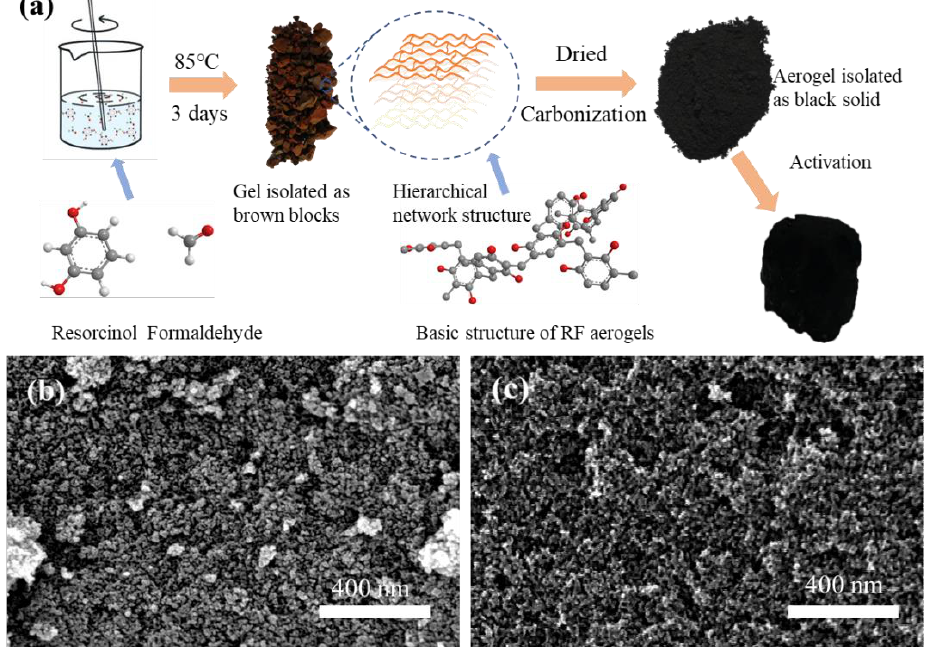
Figure 1. Fabrication and morphology of carbon aerogels. ( a ) Schematic illustration of the fabrica- tion process. Resorcinol and formaldehyde hydrosol were converted into hydrogel by hydrothermal process, freeze-dried for 24 h, and annealed at 900 °C to form the porous carbon aerogels, and the activating process built more nanostructure pores resulting in a lower reflectance. SEM images of ( b ) CA-S and ( c ) ACA. The scale bar is 400 nm.